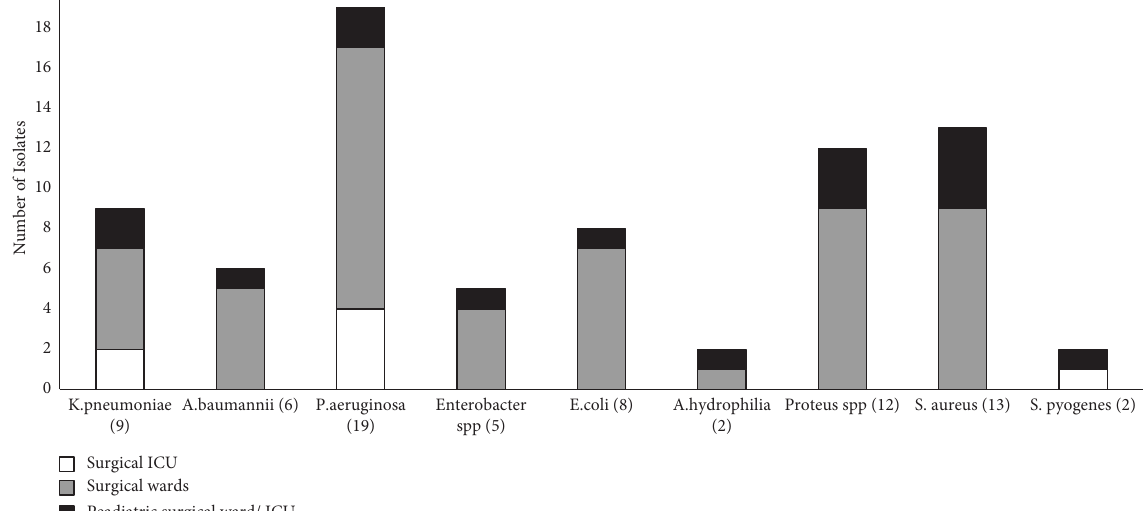
Figure 2: Te number of bacteria isolated from diferent wards. Pseudomonas aeruginosa is the most frequent pathogen isolated commonly isolated in surgical wards. Name of bacterial isolate (number of bacterial isolates).